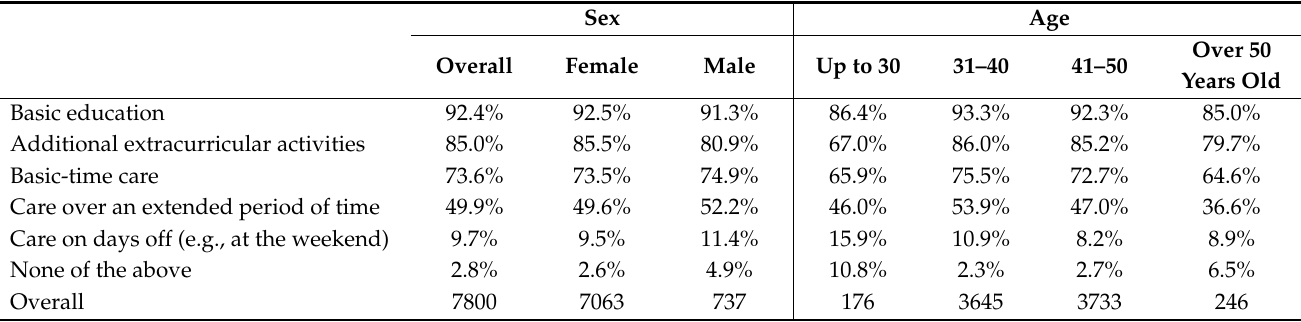
Table 4. Expected scope of activity of the school/facility (gender and age) (n = 7800).